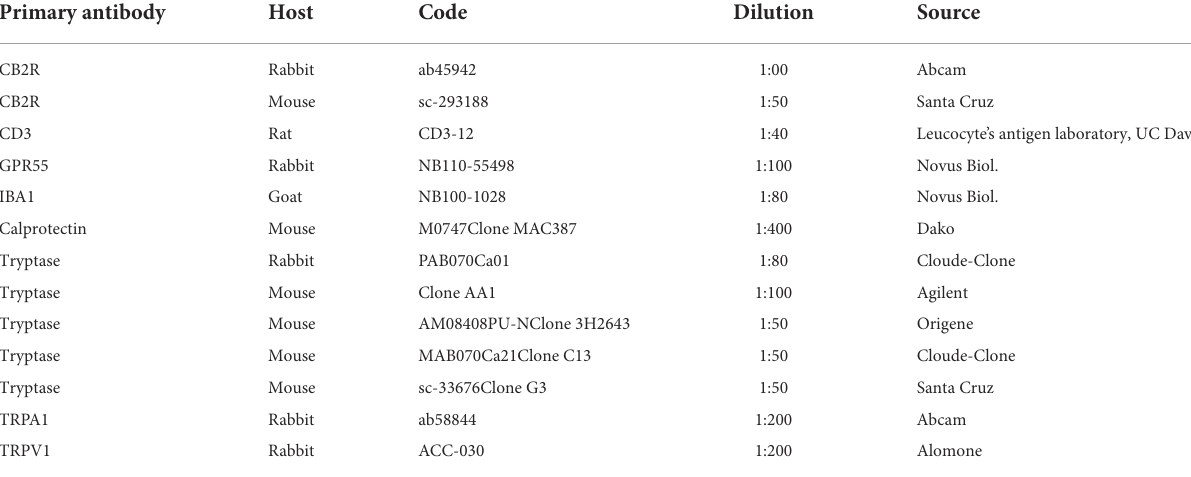
TABLE 2 Primary antibodies used in the study.